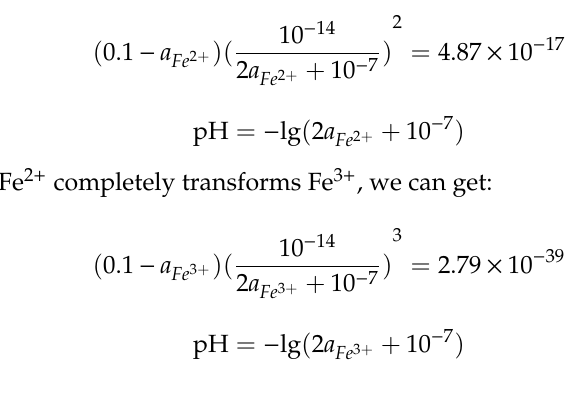
Table 3. Equilibrium electrode potential of cathodic reduction and self-corrosion potential of 304 stainless steel in 0.1 mol/L iron ion solution with different proportion of Fe 2+ /Fe 3+ . Potential V/SCE